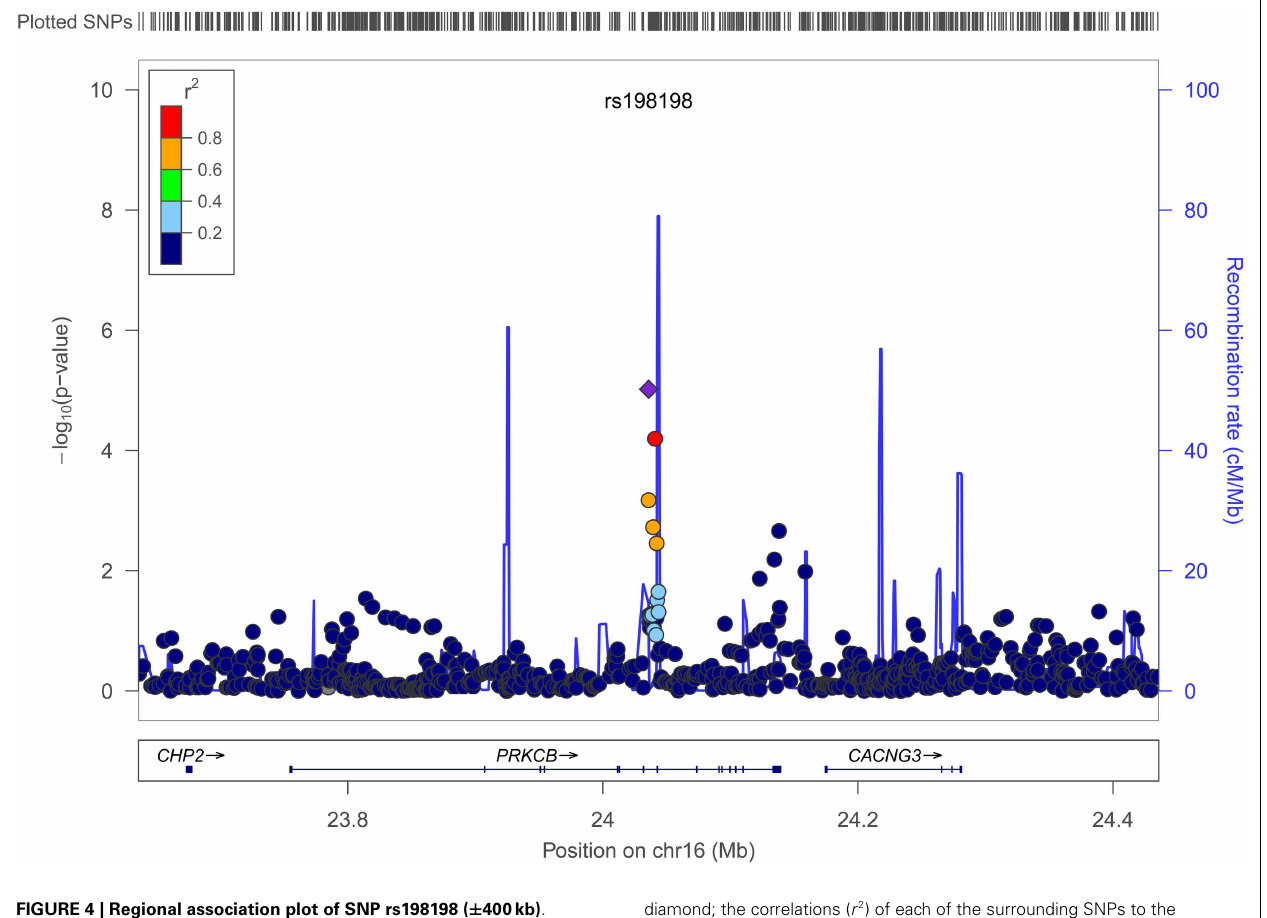
FIGURE 4 | Regional association plot of SNP rs198198 ( ± 400kb) . Statistical significance of each SNP on the –log10 scale as a function of the chromosome position.The top SNP is shown as the purple